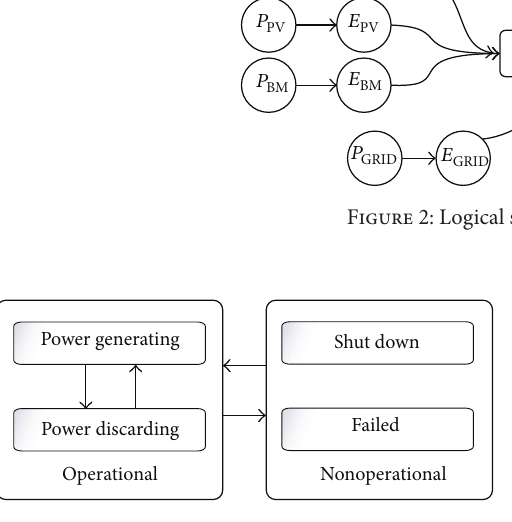
Figure 3: Statechart of the HRES generation